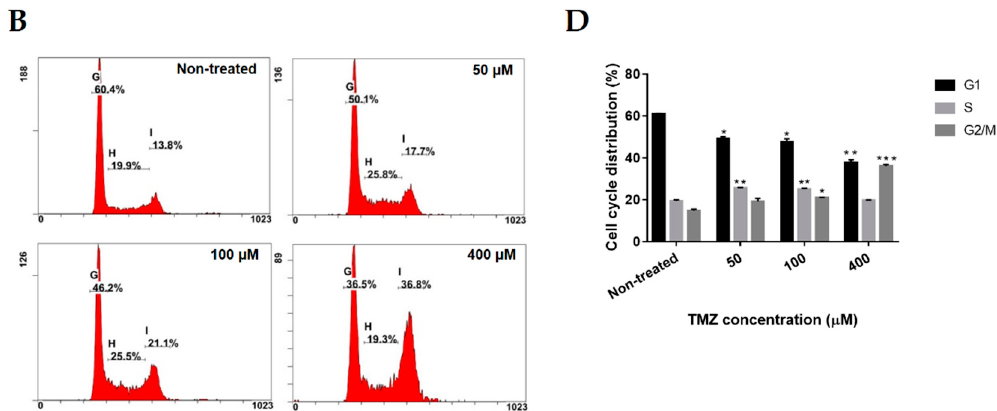
Figure 2. Neferine induces G2/M cell cycle arrest in human neuroblastoma cells. (A,B) IMR32 cells were cultured at the described concentrations of neferine (A) or TMZ (B) for 24 h, and then flow cytometry analysis was used to determine the cell cycle distributions. (C,D) The quantification of cell cycle arrest in neferine ‐ treated or TMZ ‐ treated IMR32 cells was shown. Data are expressed as mean ± SD in three independent experiments. * p < 0.05, ** p < 0.01, *** p < 0.001 as compared with the non ‐ treated control.